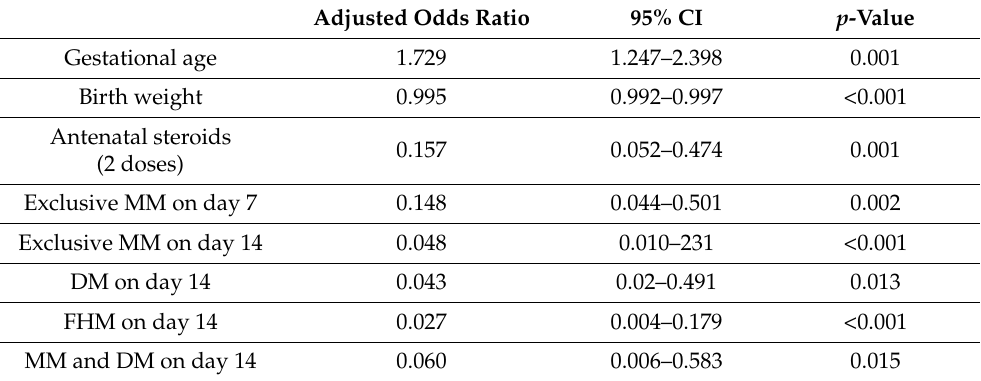
Table 6. Relationship between feeding strategies and NEC adjusted for demographic variables: results from logistic regression model on days 3, 7, and 14 together.